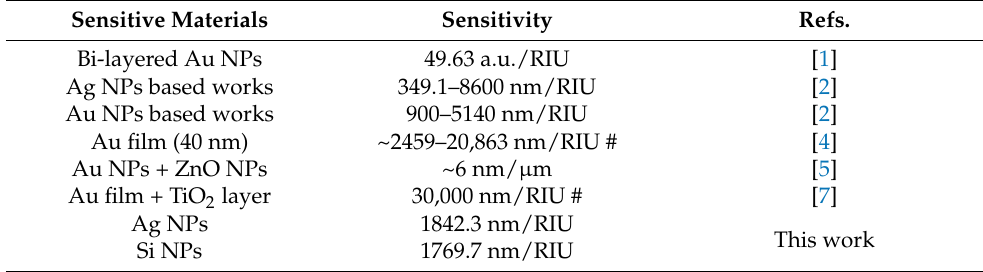
Table 2. Comparison of sensitivity for reported works and proposed